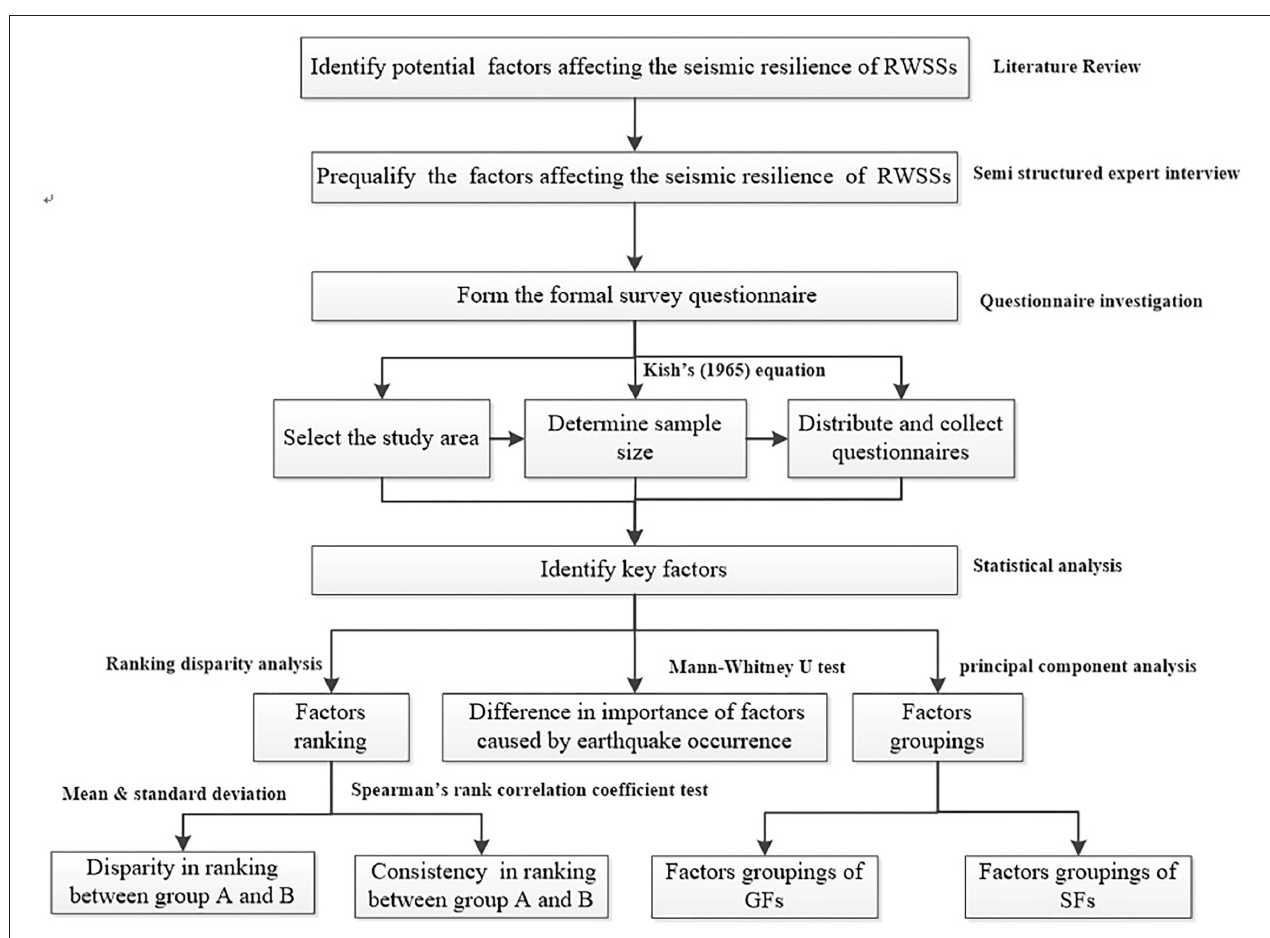
FIGURE 2 | The research process of factors affecting the seismic-resilience of